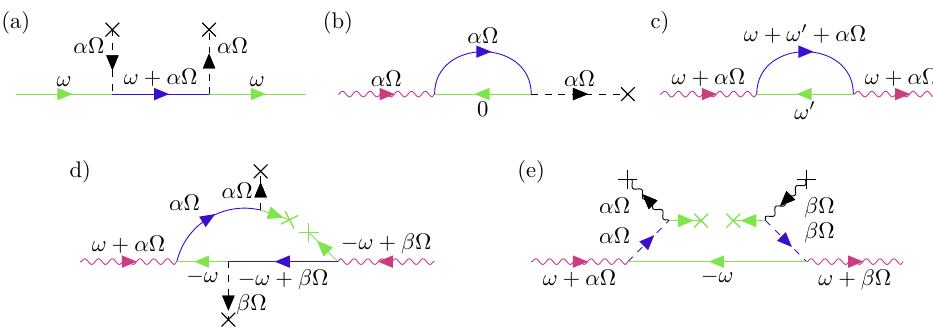
Figure 9: All the "geometrically" different Feynman diagrams describing the different ( g 2 ) . The notation is equivalent to the one used processes in the system up to O for the two diagrams in the Fig. 2. a) Due to the coupling to the excited-state the ground-state experiences a Stark shift. The pump excites the ground-state and the excited-state then decays by emitting into the pump. b) The process that is first order in cavity coupling. The cavity excites the atom which then decays into the laser. The opposite process also exists. c) The two-photon process which is second order in cavity coupling. A photon excites the atom and the excited state subsequently decays into the same cavity mode. This process is not amplified by the laser. d) An example of the opposite anomalous process shown in Fig. 2 (b). e) The opposite process of Fig. 2 (a) that gives the second term in the self-energy /